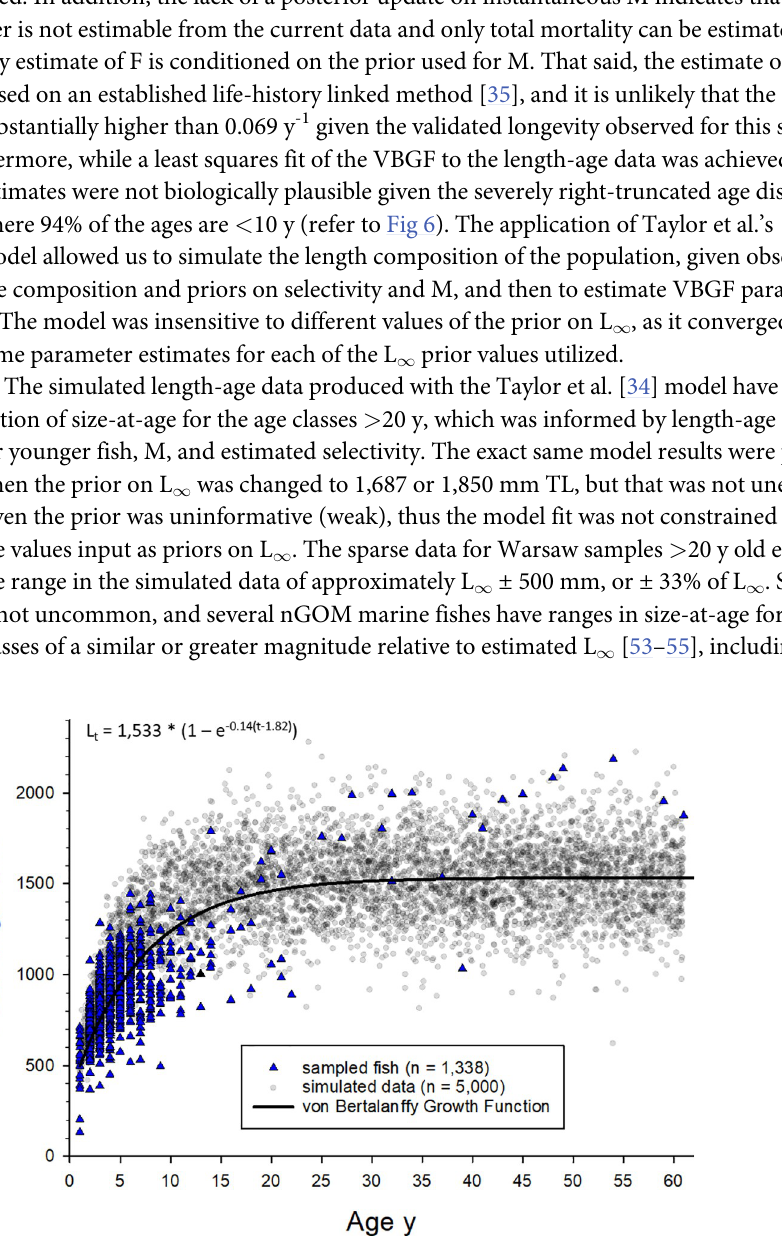
Fig 5. Northern Gulf of Mexico DIC Δ 14 C values sampled at DeSoto Canyon. Panel A is a profile of nGOM DIC Δ 14 C sampled at DeSoto Canyon stations (Fig 2) by depth. Green data points represent 200–600 m depth, which is the depth range where Warsaw grouper have been reported to reside. Panel B is a linear regression fit to the DIC Δ 14 C values for the 200–600 m depth range.